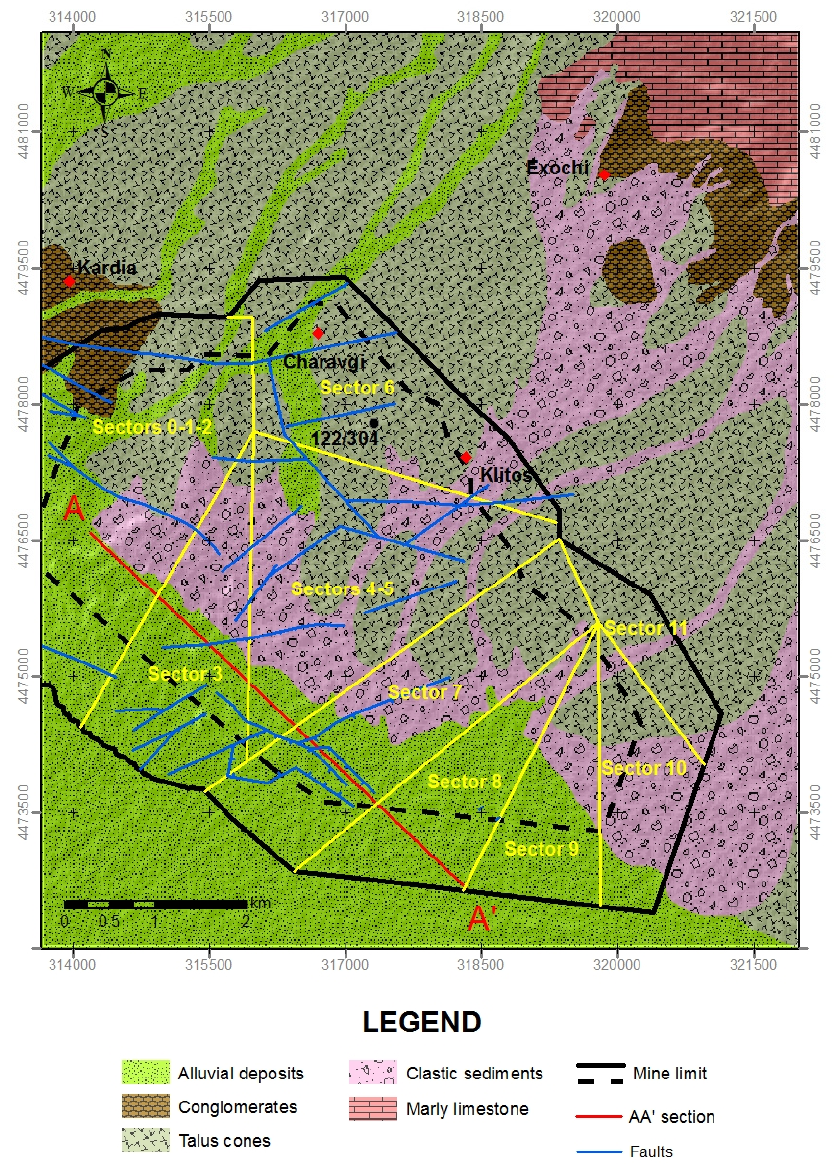
Figure 3. Geological map of the South Field mine.